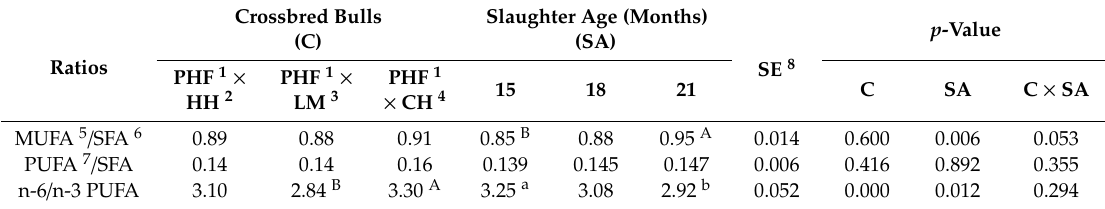
Table 7. Fatty acid ratios in the longissimus thoracis muscle of crossbred